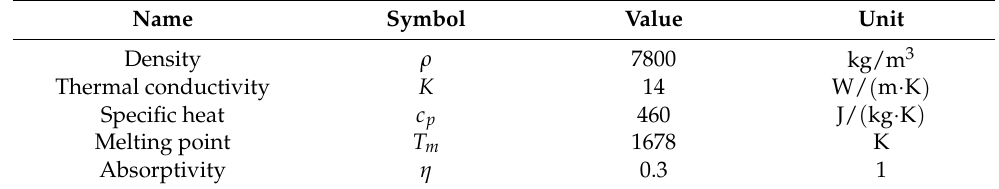
Table 1. Material properties of SS316L [18,27].